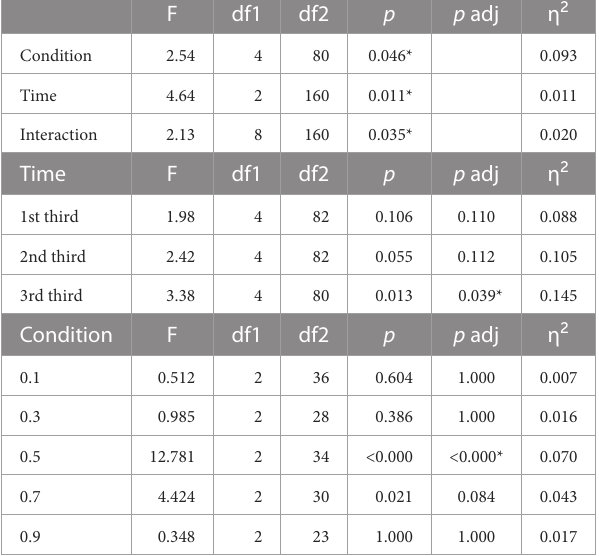
TABLE2 Top:MANOVAforthewithin-factortimeandthebetween-factor condition( α = 0 . 05 (*)).Middle:ANOVAwiththefactorconditiononthe normalizedfixationdurationoftheROIheadforeachinteractionthird. Bottom:ANOVAwiththefactortimeonthenormalizedfixationdurationof theROIheadforeachcondition.